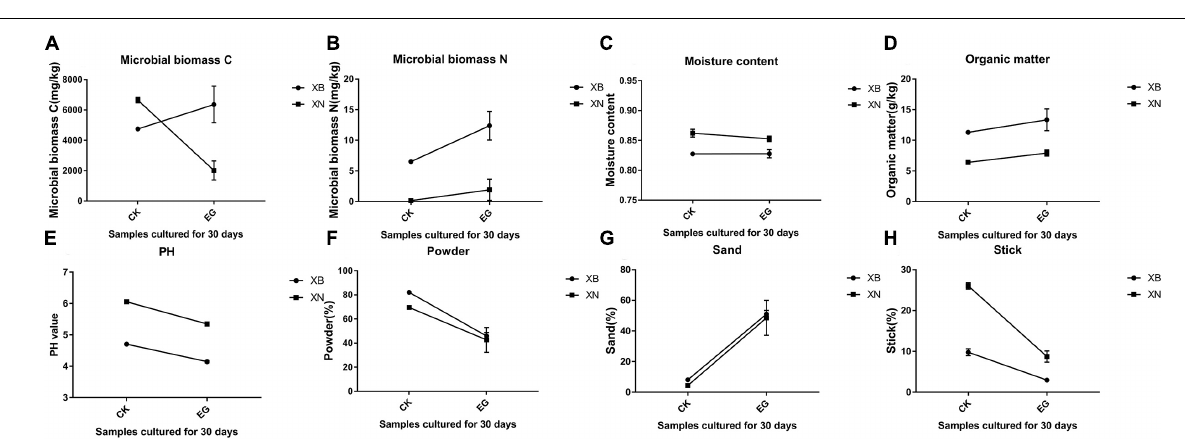
FIGURE 9 | Analysis of the properties of soil containing ethyl orthosilicate. (A) content of microbial biomass C (mg/kg), (B) content of microbial biomass N (mg/kg), (C) percentage of moisture content, (D) content of organic matter, (E) PH, (F) percentage of powder, (G) percentage of sand, (H) percentage of